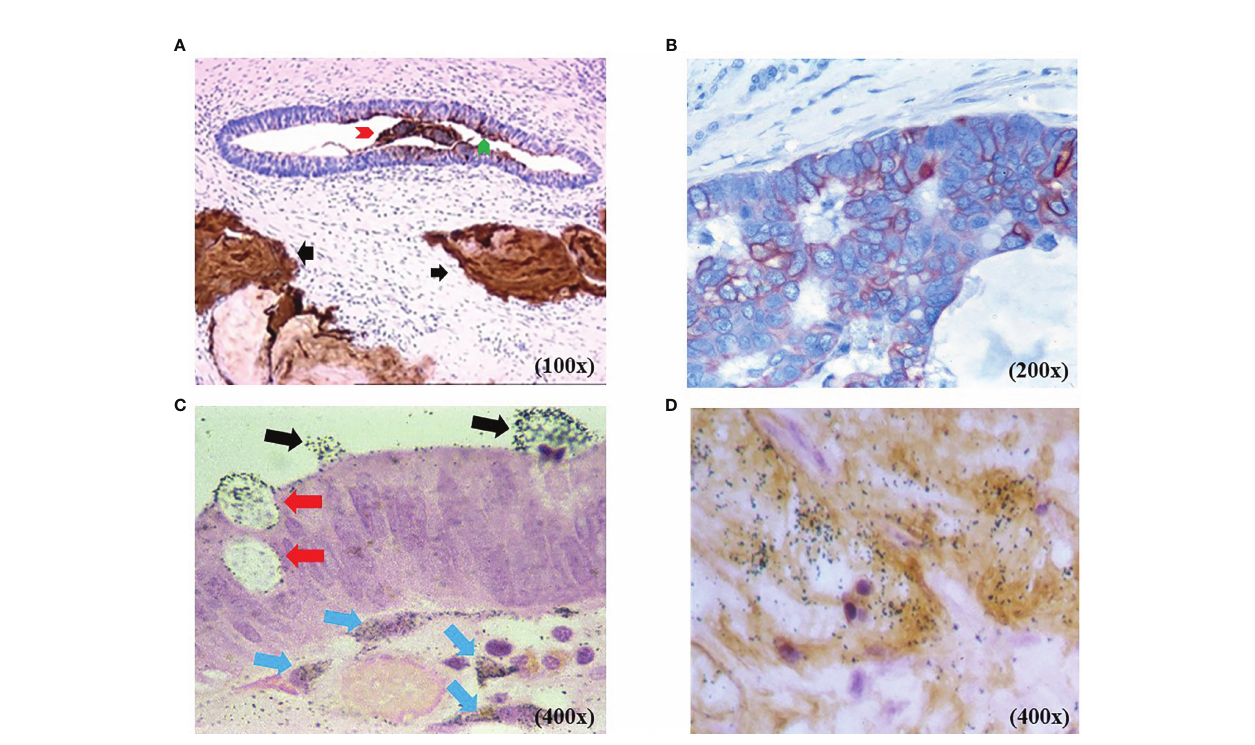
FIGURE 1 | TAG-72 expression in colorectal adenocarcinoma [colorectal carcinoma (CRC)]. (A) Non-mucinous CRC with murine monoclonal antibody (mMoAb) CC49 immunohistochemical (IHC) staining (brown) demonstrates TAG-72 in malignant glands and in mucin lakes in the tumor microenvironment (TME) (black arrows). The malignant gland exhibits TAG-72 expression in the luminal contents (red arrow head), cytoplasmic vacuoles, and the tumor cells ’ luminal surface (green arrow head). (B) Non-mucinous CRC with mMoAb CC49 IHC staining (brown) demonstrates TAG-72 outlining the plasma membrane of the malignant cells. (C) Black autoradiography silver grains (ARGs) of the injected mMoAb 125 I-CC49 demonstrates 125 I-CC49-bound TAG-72 in cytoplasmic secretory vesicles (red arrows) in CRC cells as they move from the cytoplasm to the lumen of a malignant gland (black arrows). Below the malignant cells are ARGs in the cytoplasm of dendritic- shaped cells (blue arrows) in TME. (D) Co-localization of the injected 125 I-mMoAb CC49 (black ARGs) overlapping with the IHC staining (brown) for TAG-72 demonstrates the TAG-72 antigenic epitope in the TME of a